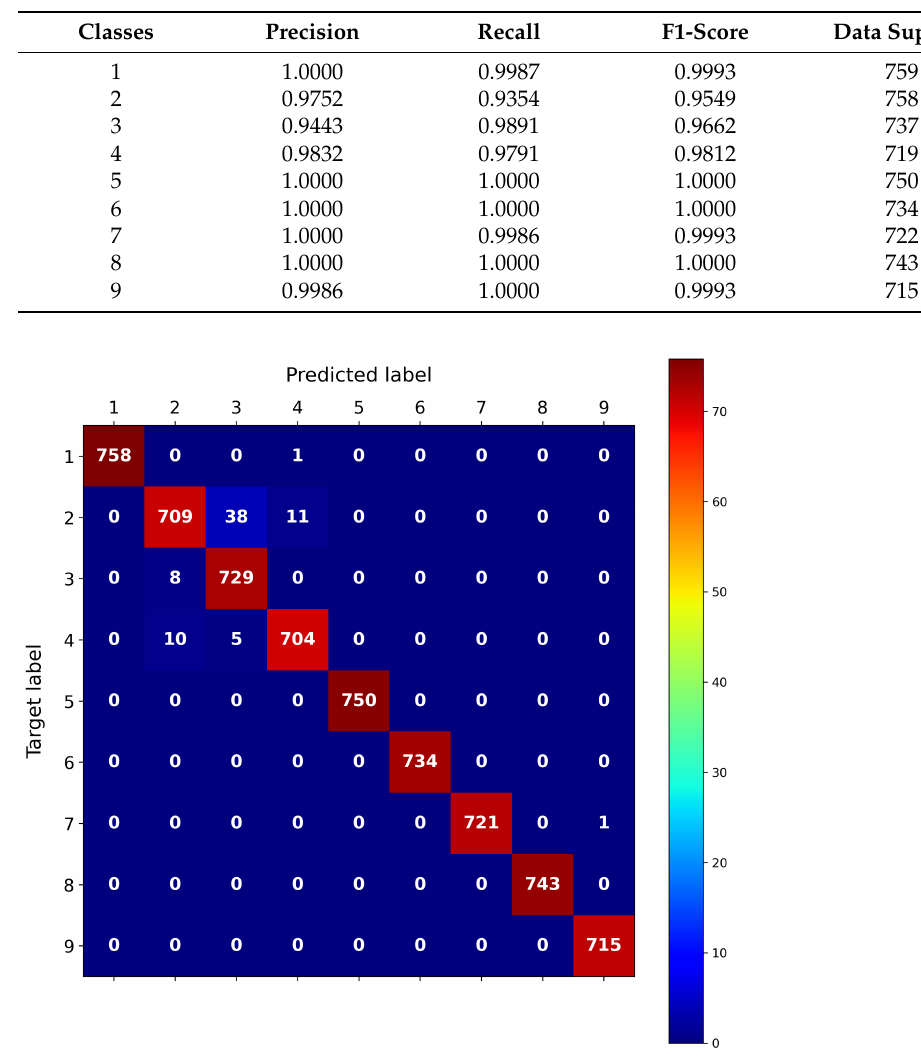
Figure 7. Confusion matrix of the CNN model for 9 classes of